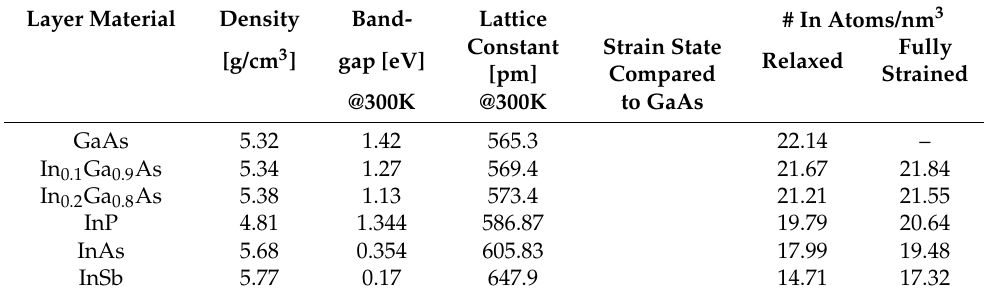
Table 1. Materials properties used in simulations and volume density of indium atoms for various overlayer materials considered. Note that materials with a larger lattice constant have fewer In atoms in an equivalent layer of 1 nm thickness. Layer Material Density Band- Lattice # In Atoms/nm 3 Fully Constant Strain State Relaxed [g/cm 3 ] gap [eV] Strained [pm] Compared @300K @300K to GaAs GaAs In 0.1 Ga 0.9